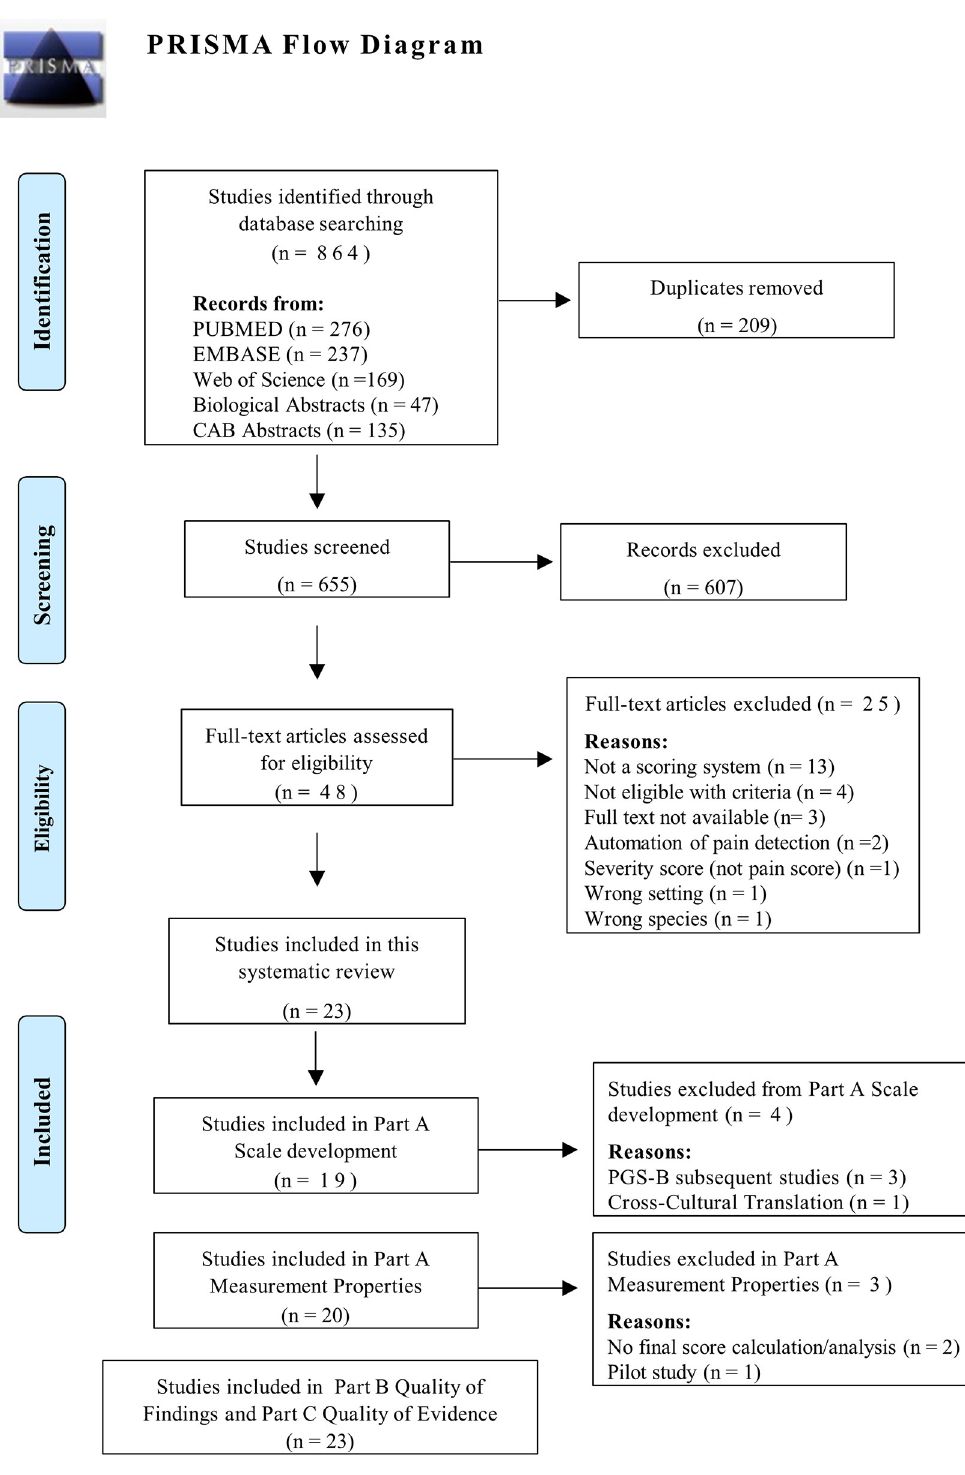
Fig 1. PRISMA flow diagram of studies on the measurement properties of pain scoring instruments for farm animals. From : Moher D, Liberati A, Tetzlaff J, Altman DG, The PRISMA Group (2009). P referred R eporting I tems for S ystematic Reviews and M eta- A nalyses: The PRISMA Statement. PLoS Med 6(7): e1000097. doi: 10.1371/joumal.pmedl000097 For more information, visit